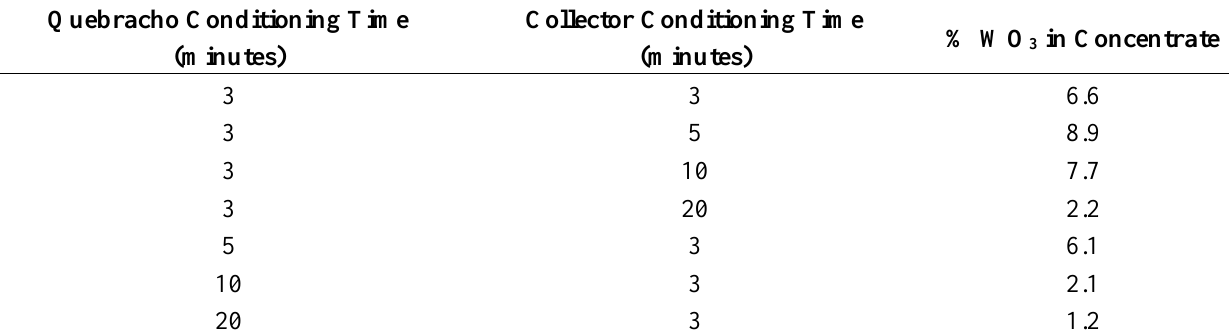
Table 2. Conditioning Time Data